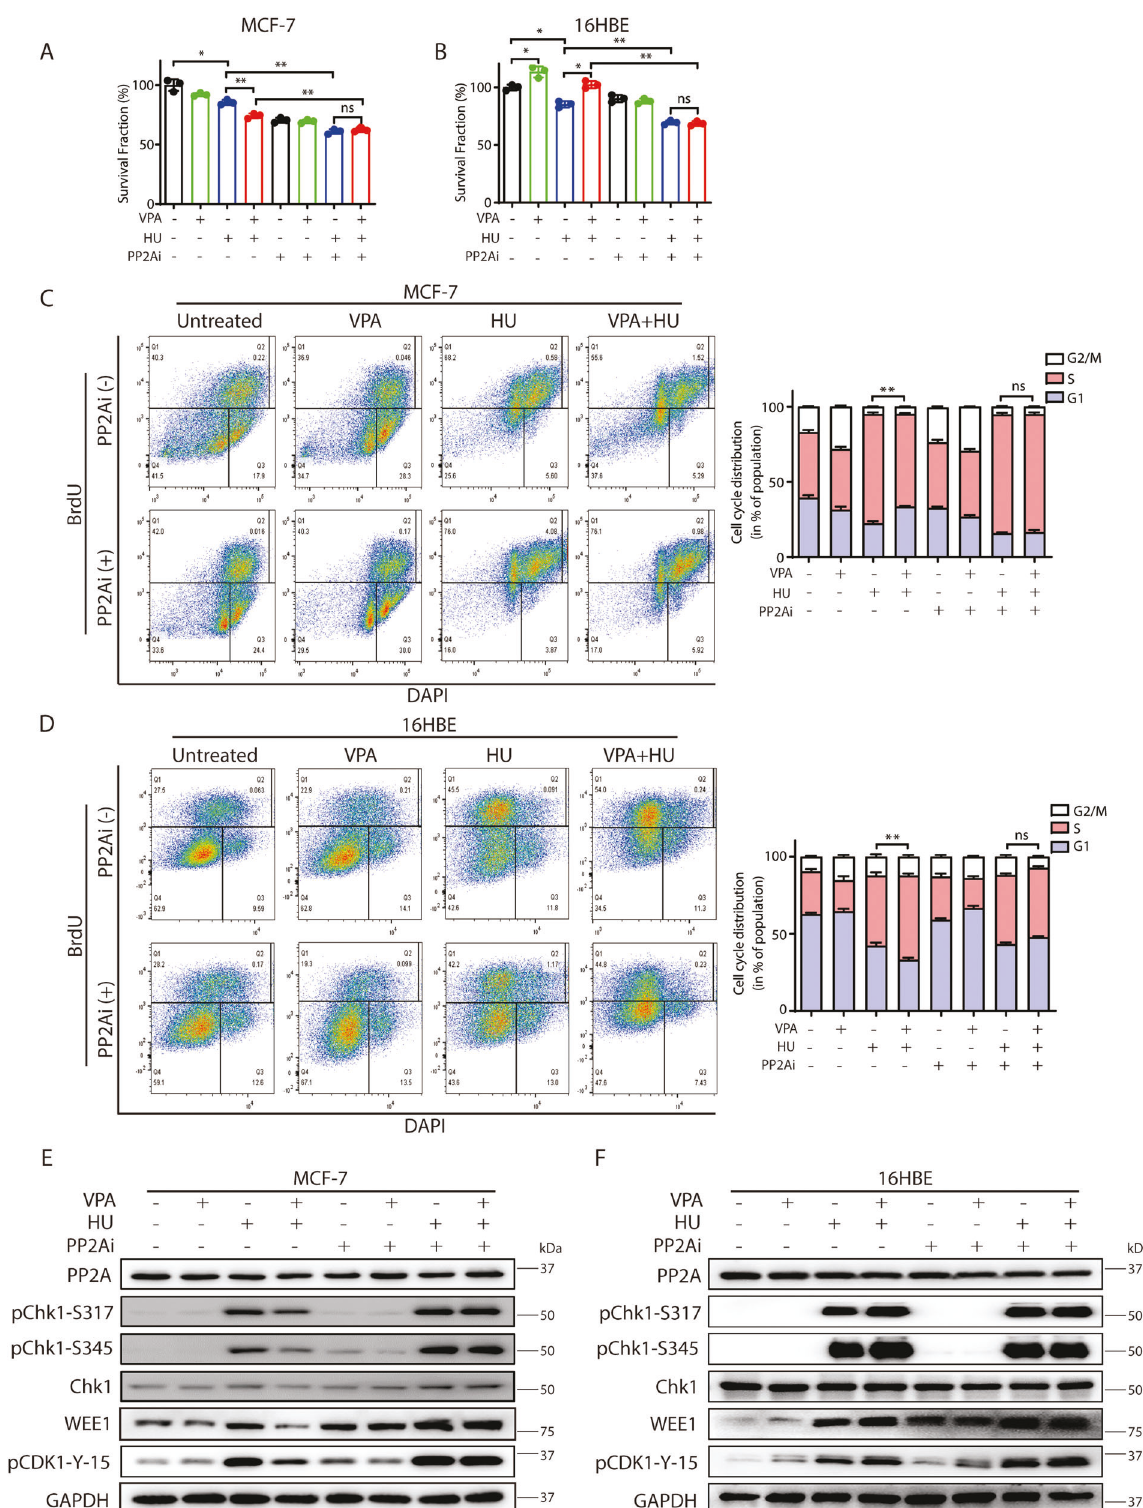
Fig. 2 Phosphatase PP2A participates in VPA-mediated bidirectional regulation under HU treatment. A , B Survival fraction of MCF-7 and 16HBE cells after exposure to 0.5 mM VPA, 2 mM HU or/and 2.5 μ M PP2A inhibitor (PP2Ai) LB-100 were detected by CCK8 assay. Quanti fi cation was from three independent experiments. * P < 0.05, ** P < 0.01; ns, not signi fi cant. C , D MCF-7 and 16HBE cells were treated as stated in A and B . Cell cycle analysis of the DNA content of MCF-7 and 16HBE cells were analyzed by fl ow cytometry. Cell cycle analysis is shown as mean ± SD ( n = 3). Statistical signi fi cance is displayed for S cells. ** P < 0.01; ns, not signi fi cant. E , F MCF-7 and 16HBE cells were treated as described in A and B , whole-cell lysates were subjected to Western blotting analysis. GAPDH was used as loading control. Cell Death and Disease (2023)